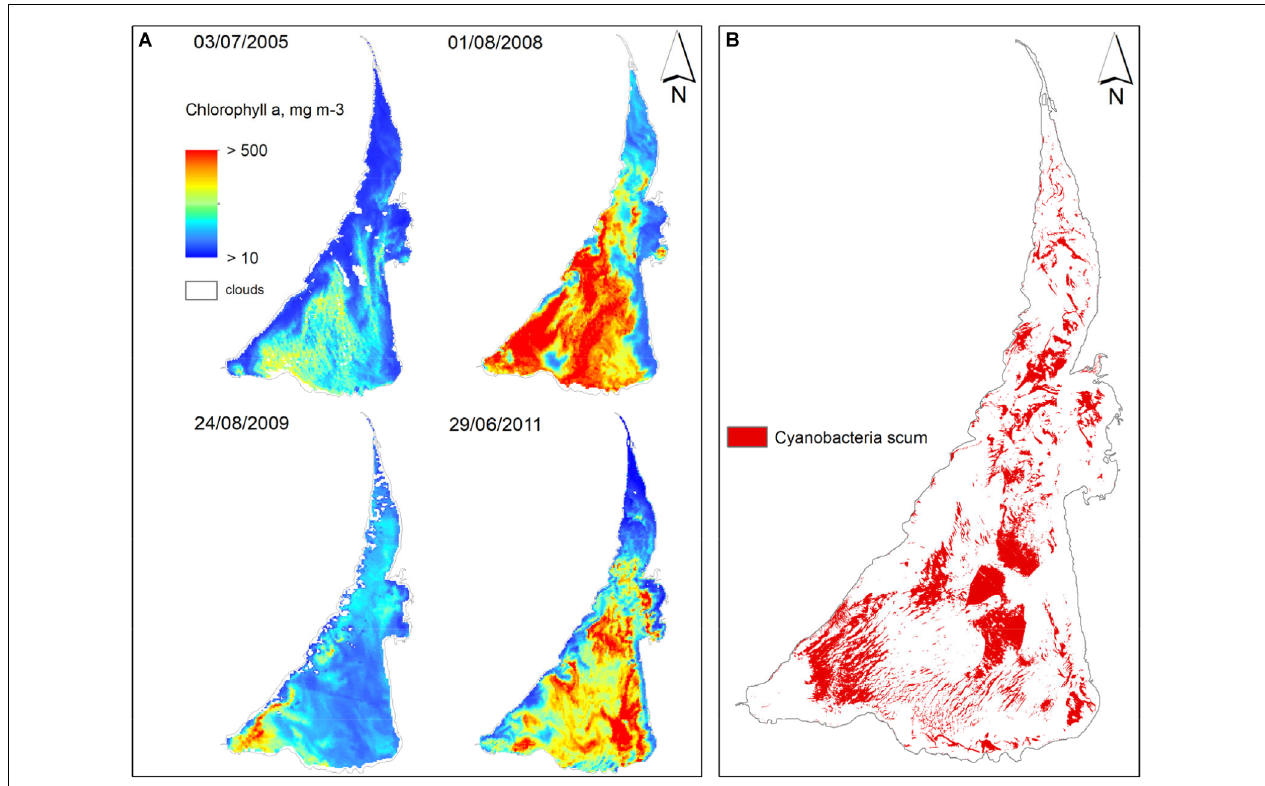
FIGURE 2 | Maps of Chl-a concentrations in the Curonian Lagoon from MERIS images (A) and cyanobacteria surface accumulations as retrieved by Landsat-8 OLI and Sentinel-2 MSI during June-September 2013-2016 (B) .